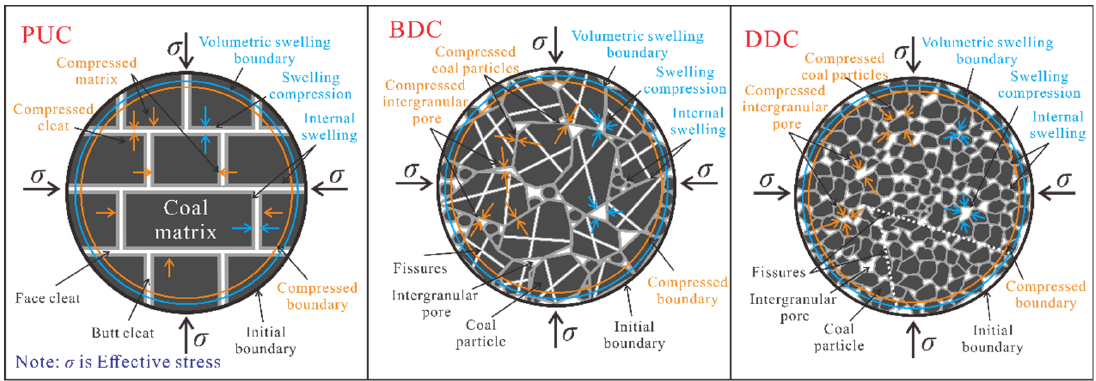
Figure 13. The absorption models of PUC and TDC cores under effective stress.